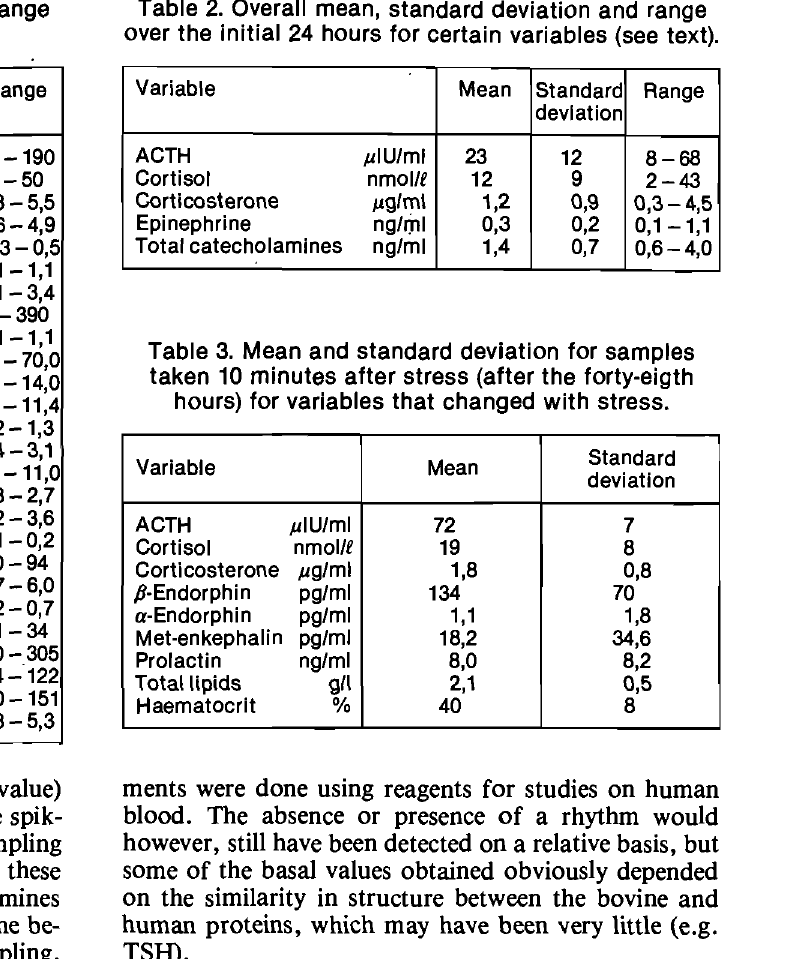
Table 2. Overall mean, standard deviation and range over the initial 24 hours for certain variables (see text).